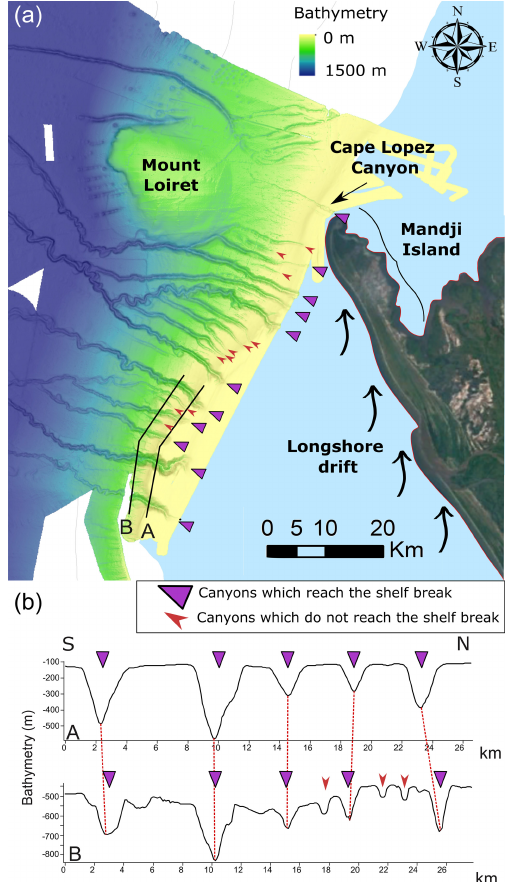
Figure 3. (a) Close-up view of the Gabon shelf and canyons ramp. Bathymetry is from the Optic Congo2005 and MOCOSED2010 sur- veys; satellite view is from Google Earth. (b) Two bathymetric pro- files across the canyons showing the two types of canyons which are present along the Gabonese slope.